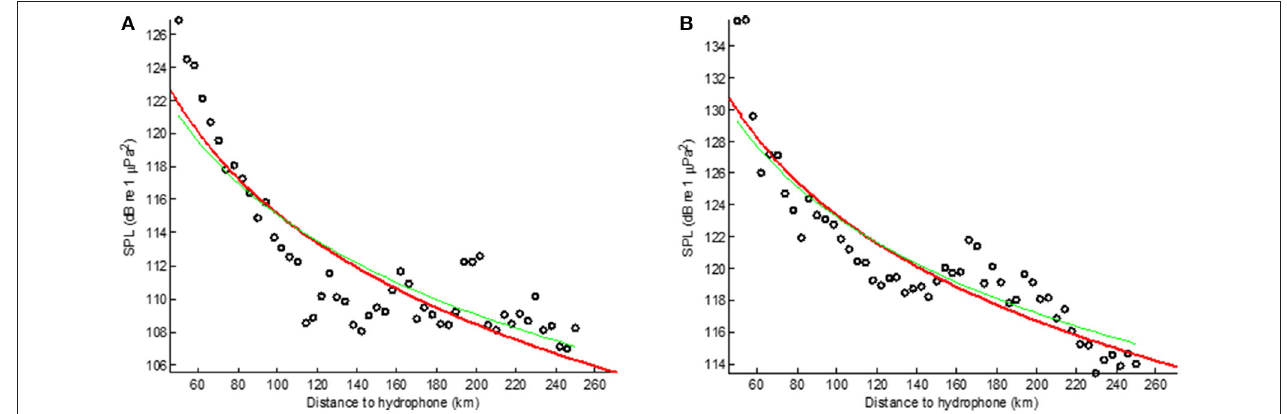
FIGURE 7 | Logarithmic fit on the sound levels of the third octave band centered on 40 Hz for measurements from 50 km away and binned at 4 km intervals; (A) Greenland I and (B) Greenland II. The green line represents spherical loss, the red line an optimal logarithmic fit, in both cases − 22 log 10 (R); the residual RMS was 2.3 dB (A) and 2.0 dB (B) . These curves are based on summer data from August to October